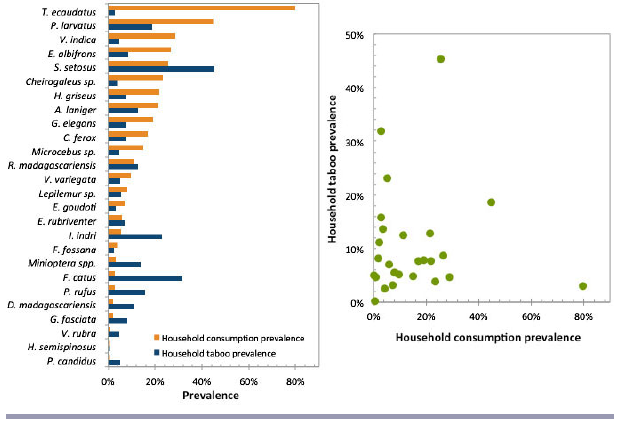
Fig. 2 . Patterns of household taboo and consumption of wildlife. At a community level, there is no significant inverse relationship between the prevalence of species-specific food taboos (blue) and the level of consumption of that species (orange). See Appendix 1 for full scientific and common